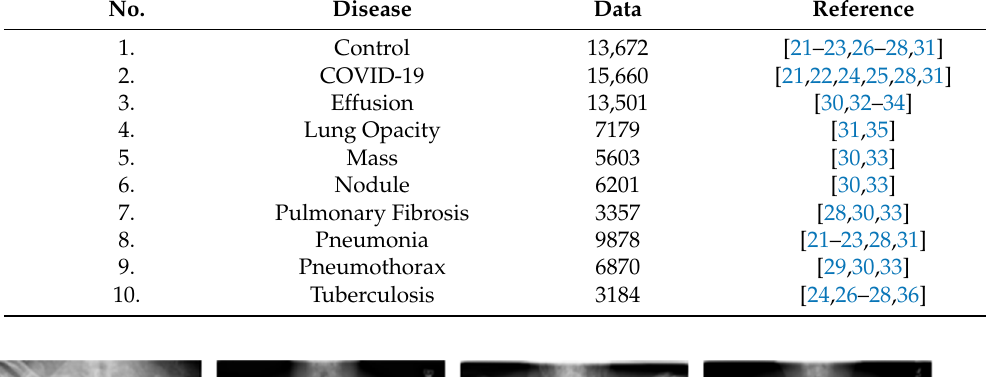
Table 2. The raw dataset’s description.